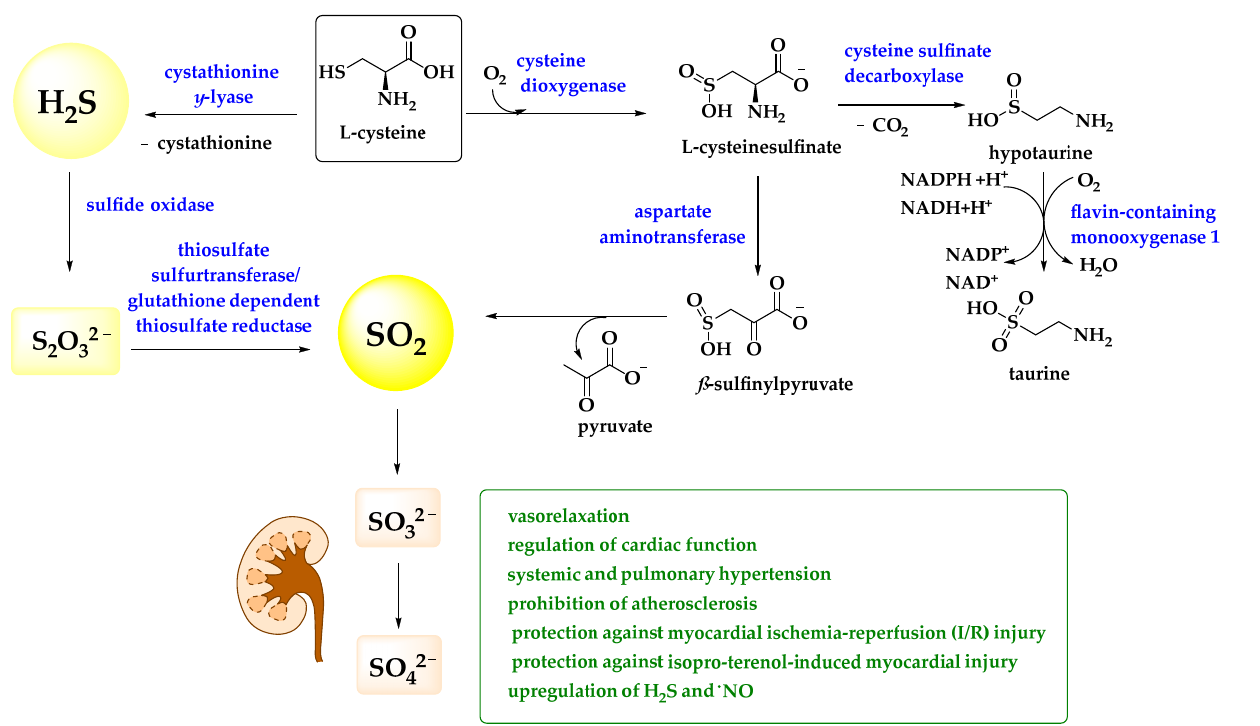
Figure 2. In humans, SO 2 is produced from L-cysteine and metabolized to SO 32 − and SO 42 − , which are excreted via the urine. A brief list of biological activities is provided and more details can be found in the text [62–64].